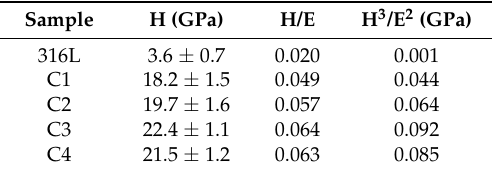
Table 3. The hardness, H/E and H 3 /E 2 of 316L substrate and CrN films.